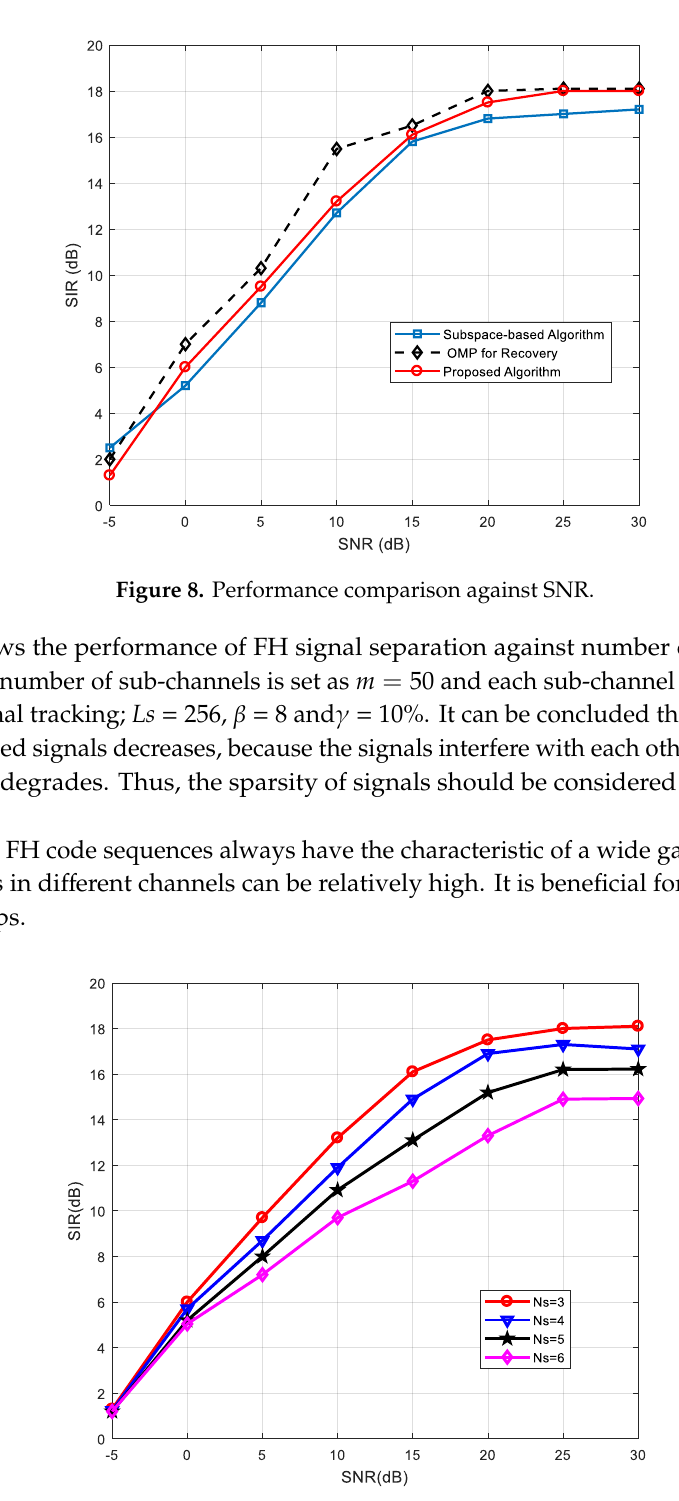
Figure 9. Performance of separation against number of source.